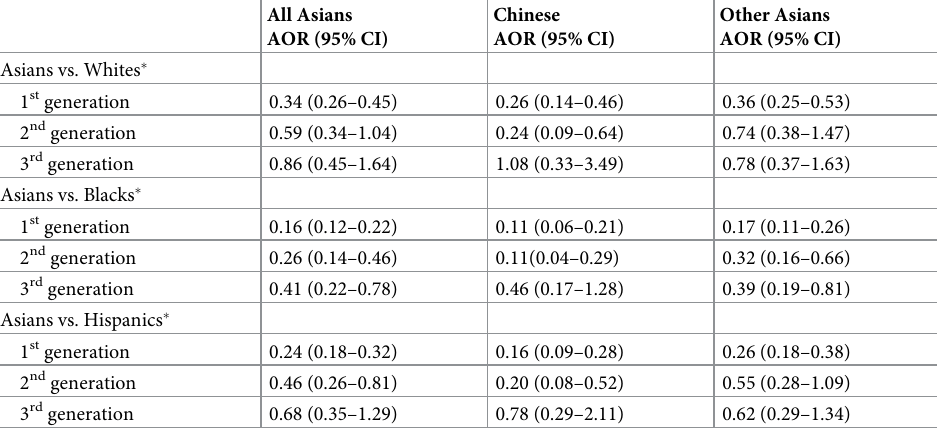
Table 2. Multiple logistic regression analyses for the association between immigration generations and obesity among Californian adults, CHIS 2013–2014.